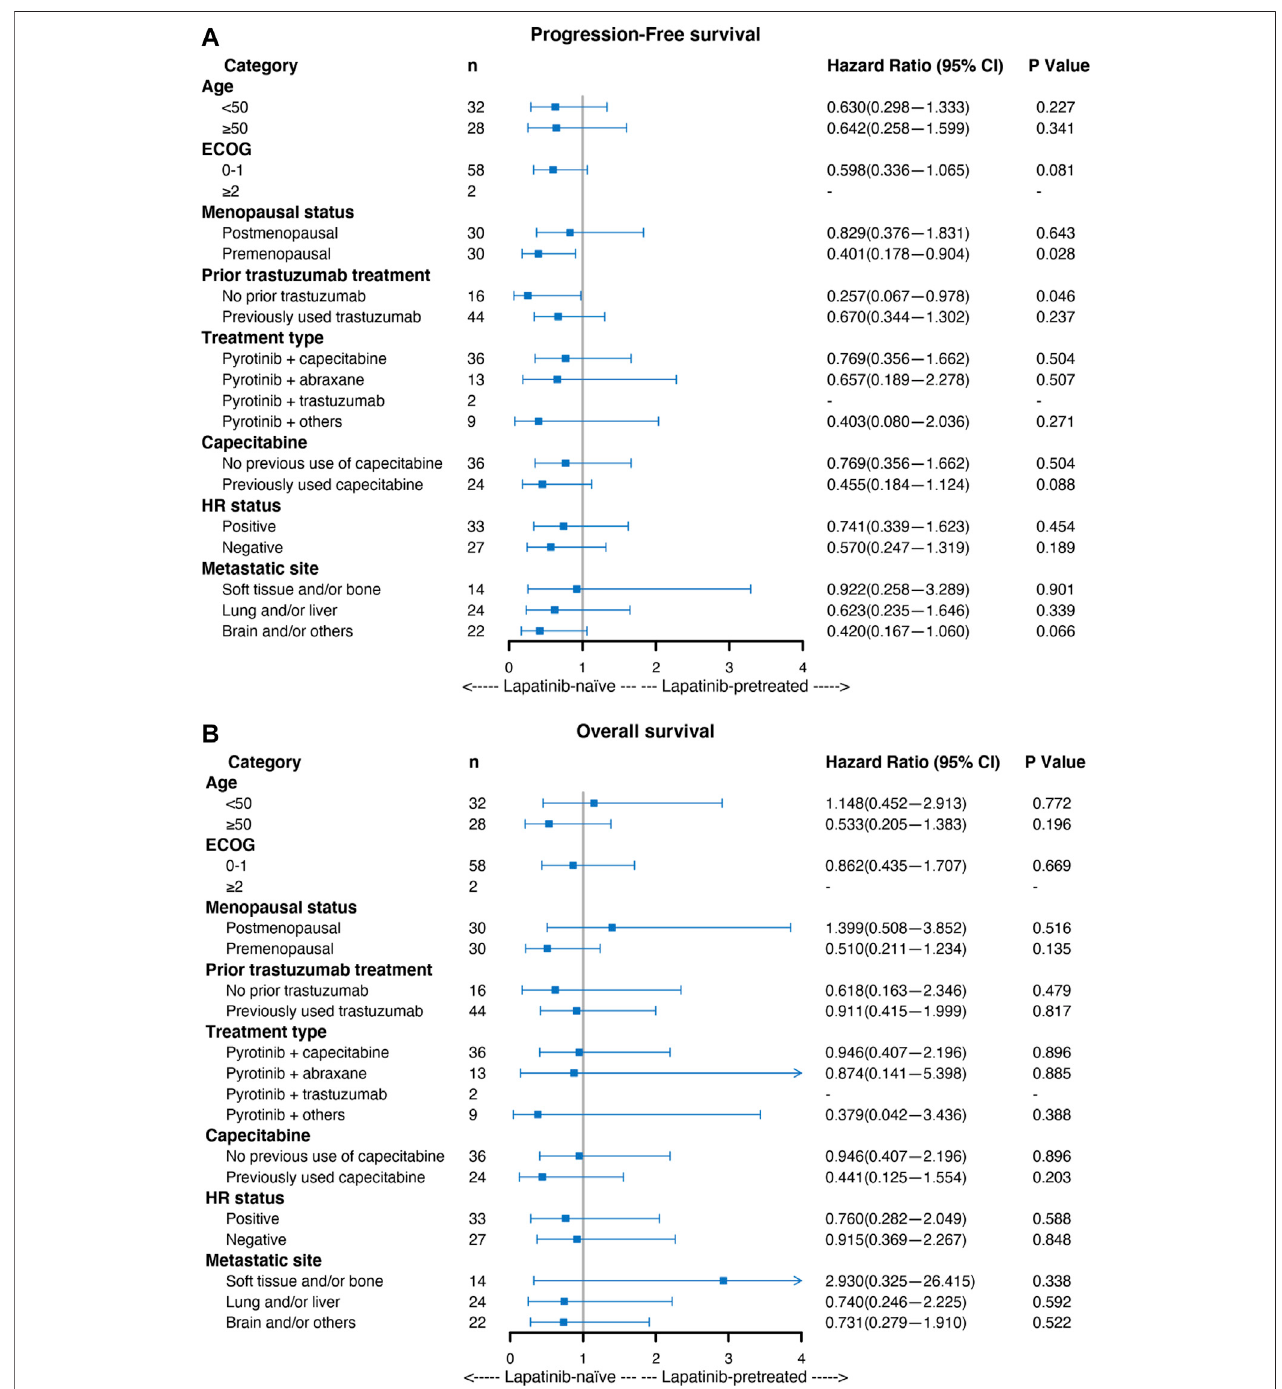
FIGURE3| Forestplotofthesubgroup analysisofpatientswithHER2-positiveMBCwithregardto (A) progression-freesurvival(PFS)and (B) overallsurvival(OS). The hazard ratio (HR) and 95% con fi dence interval (CI) and the p -values were determined by Cox proportional hazard regression.